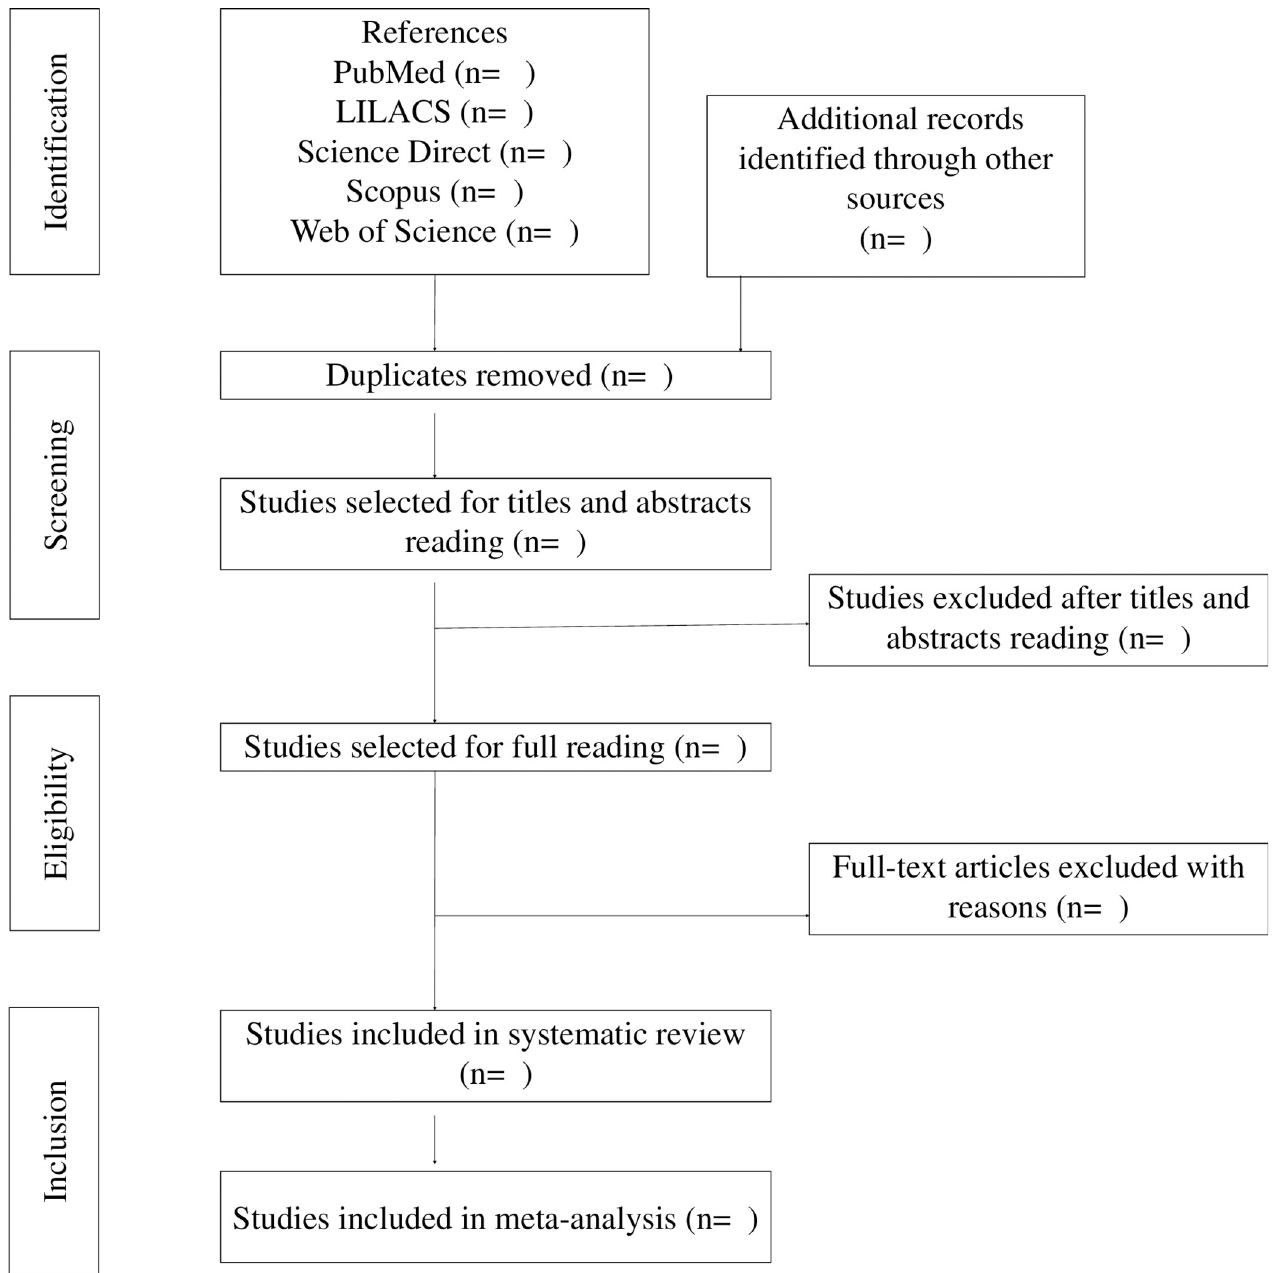
Fig 1. Flowchart. Adapted from